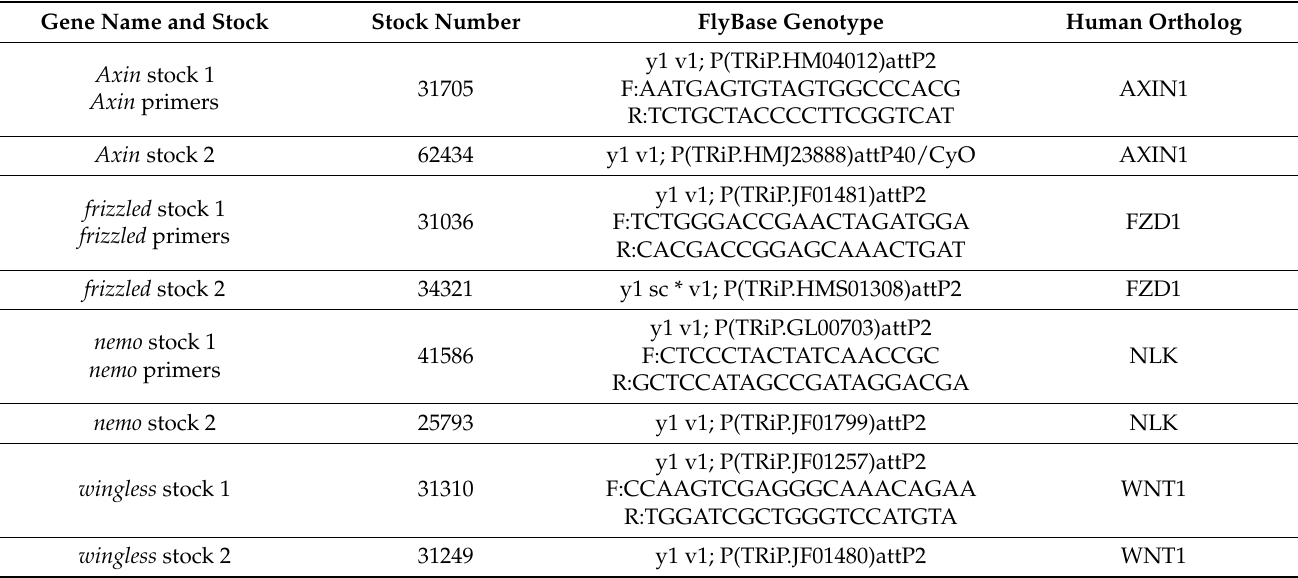
Table 1. List of RNAi TRiP lines used to validate candidate genes and primers used to amplify cDNA for